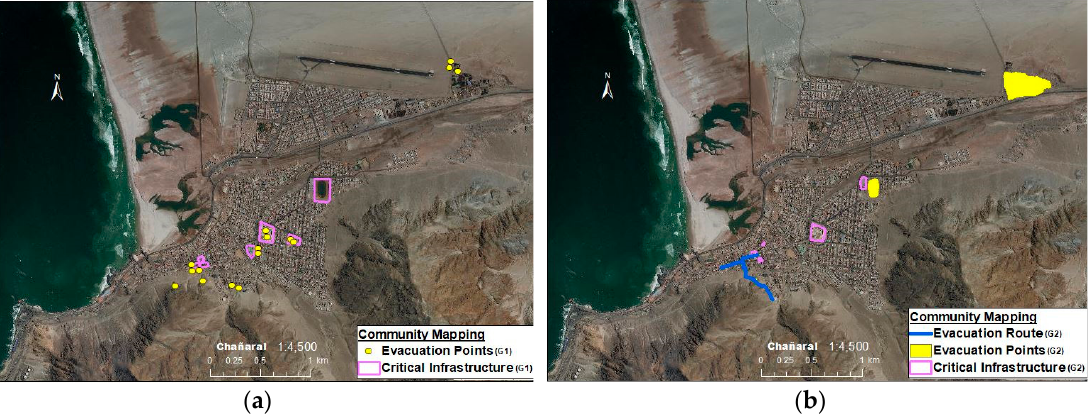
Figure 12. Critical Evacuation Infrastructure in Chañaral: ( a ) Group 1, ( b ) Group 2.